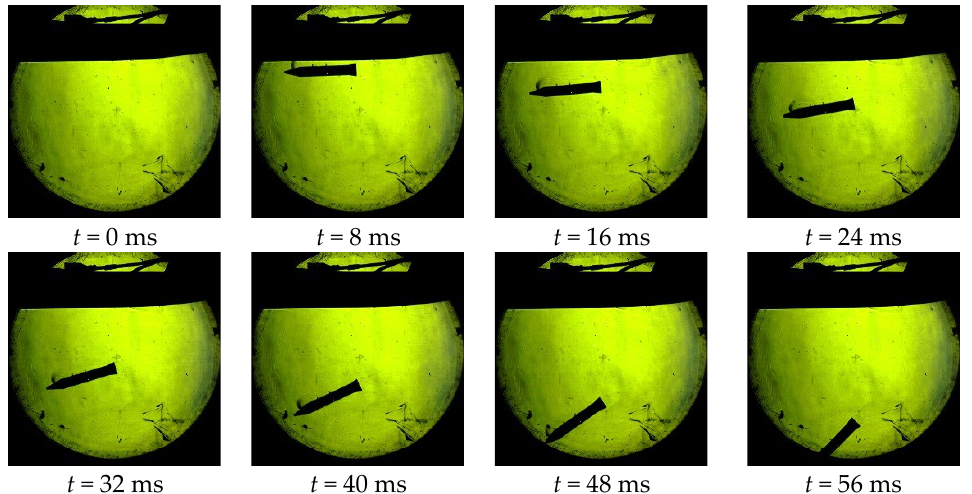
Figure 13. Test image of the revolution body’s angle of attack change with a jet at 2.0 MPa for M = 0.6.